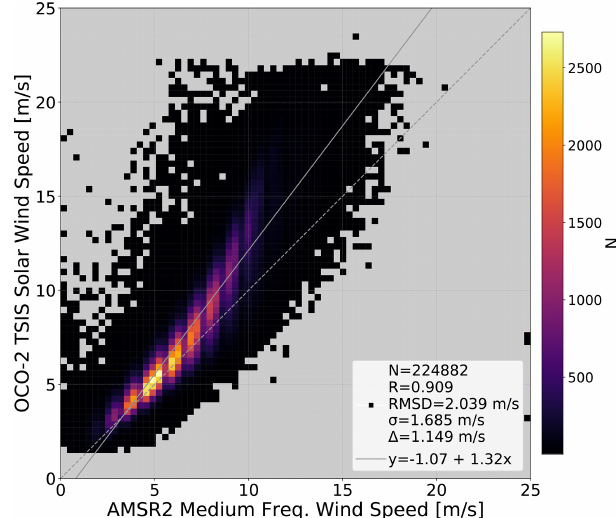
Figure 1. Heatmap of OCO-2 B9 wind speed compared to AMSR2 medium-frequency wind speed. The B9 lite file quality flag has been applied, along with a height scaling. N is the number of retrievals, R is the correlation coefficient, RMSD is the root mean square devia- tion of the two datasets, σ is the standard deviation between the two datasets, (cid:49) is the mean difference, the dashed line is a one-to-one line, and y is a linear fit plotted as a solid line.